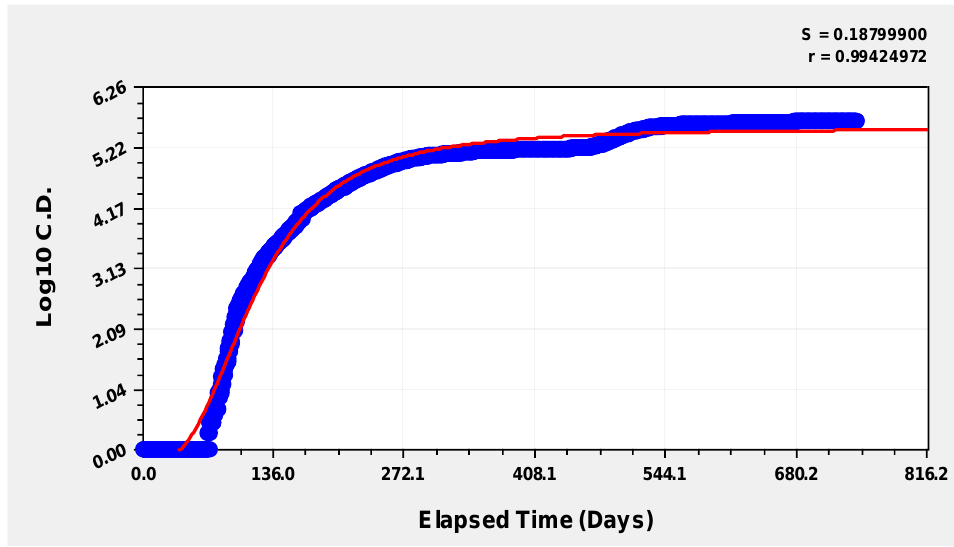
Figure 6. MMF modeling of the kinetics of the transformed Cumulative Cases (C.C.) and Deaths (C.D.) for COVID-19 reported in India